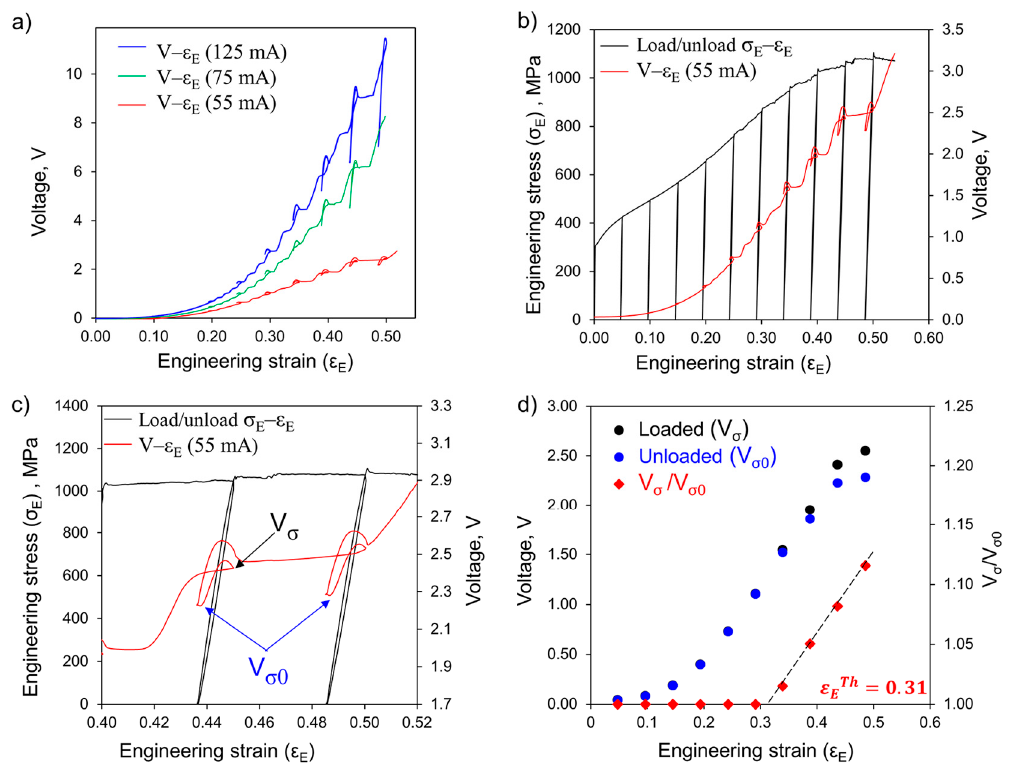
Figure 6. ( a ) Evolution of inductive signals with engineering strain ( ε E ) obtained during the course of cyclic load/unload tests by using currents of 125, 75, and 55 mA. ( b ) Load–unload σ E - ε E curve and inductive signal obtained with a current of 55 mA. ( c ) Magnification of ( b ) for the range ε E = 0.40–0.52. V σ 0 and V σ stand for voltage signal at zero stress and under stress, respectively. ( d ) Evolution of both the voltage signal in the loaded ( V σ ) and the unloaded ( V σ 0 ) states recorded during the load-unload cyclic measurements.